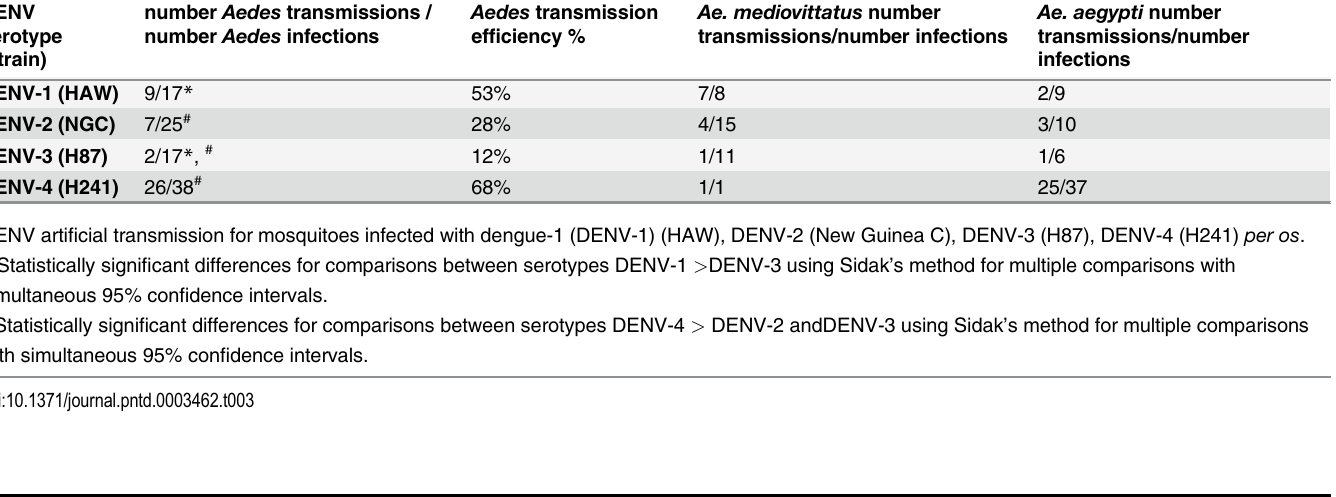
Table 3. Transmission ef fi ciency of dengue virus infected Aedes mediovittatus and Aedes aegypti mosquitoes at 14 days. DENV serotype